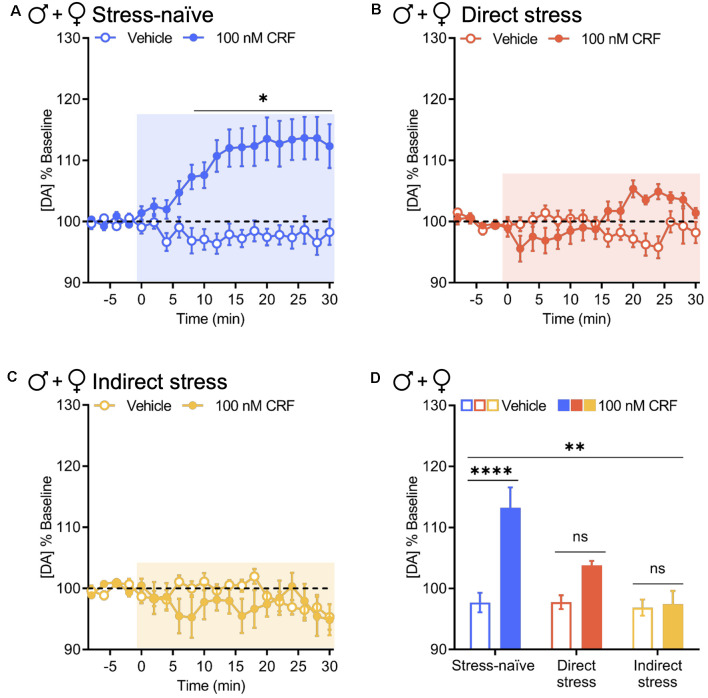
Direct and indirect stress disrupt CRF-mediated dopamine release in the NAc 1 week after stress exposure. Baseline-normalized mean peak amplitude of electrically evoked dopamine release over time in response to vehicle or 100 nM CRF application to NAc slices collected from panel (A) stress-naïve males and females (vehicle and 100 nM CRF: n = 19); (B) directly stressed males and females 1 week after rFSS exposure (vehicle and 100 nM CRF: n = 10); and (C) indirectly stressed males and females 1 week after cage mates were subjected to direct stress (vehicle: n = 12, 100 nM CRF: n = 11). (D) Baseline-normalized mean peak amplitude of dopamine release 20–30 min after vehicle or 100 nM CRF application to NAc slices from stress-naïve (vehicle and 100 nM CRF: n = 19), directly stressed (vehicle and 100 nM CRF: n = 10), or indirectly stressed (vehicle: n = 12, 100 nM CRF: n = 11) males and females. Error bars, SEM. ns: P > 0.05, *P < 0.05 vs. vehicle, **P < 0.01 vs. vehicle, ****P < 0.0001 for interaction.